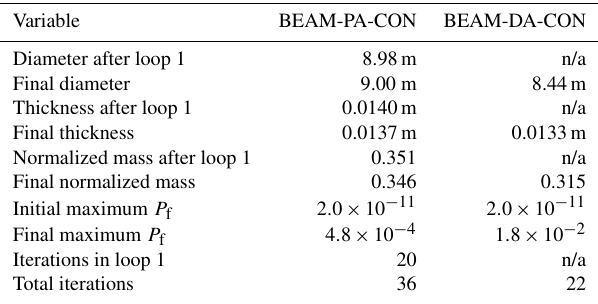
Table 5. Summary results of cases BEAM-PA-CON and BEAM-